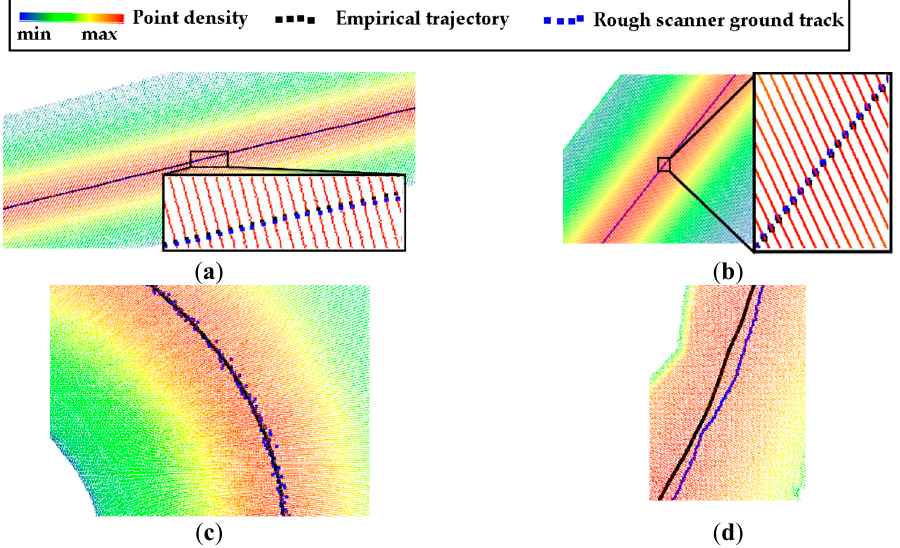
Figure 13. The scanner's rough ground track of four typical environments. ( a ) Data 1. ( b ) Data 4. ( c )